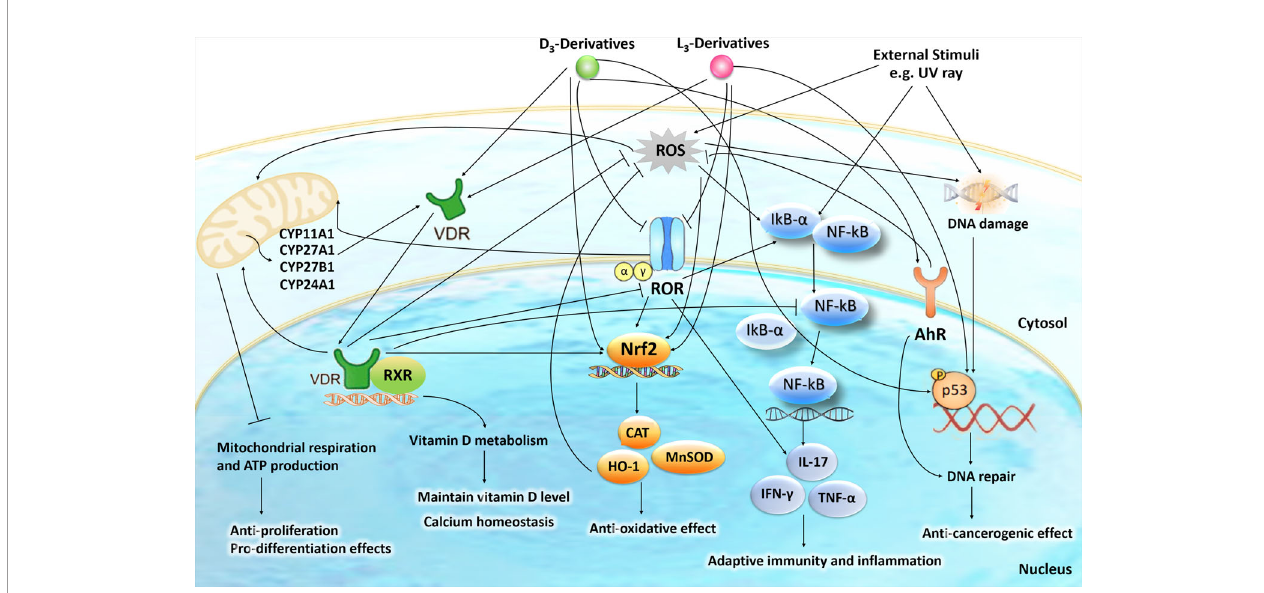
FIGURE 1 | The intracellular action of vitamin D3 (D3)- and lumisterol (L3)-hydroxyderivatives in photoprotection against UVR. Signal transduction includes the activation of nuclear receptors such as vitamin D receptor (VDR), retinoic acid orphan receptor (ROR) a / g , and aryl hydrocarbon receptor (AhR) and the direct action of D3- and L3-hydroxyderivatives on mitochondrial processes. The nuclear receptors activities are linked with the transcriptional master regulators NRF2 (nuclear factor erythroid-derived 2-like 2), p53 and NF k B (nuclear factor kappa-light-chain-enhancer of activated B cells) to coordinate anti-oxidative, DNA repair, anti- in fl ammatory, and antiproliferative as well as anti-carcinogenesis mechanisms. The fi gure is reprinted from (45) with a permission from the